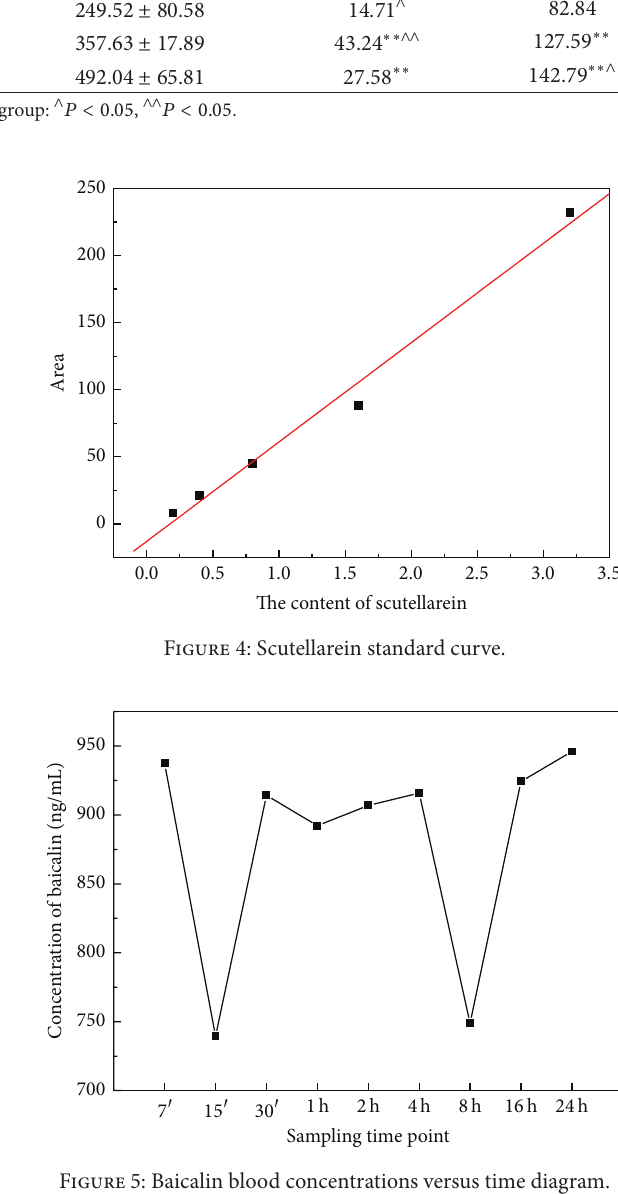
Figure 5: Baicalin blood concentrations versus time